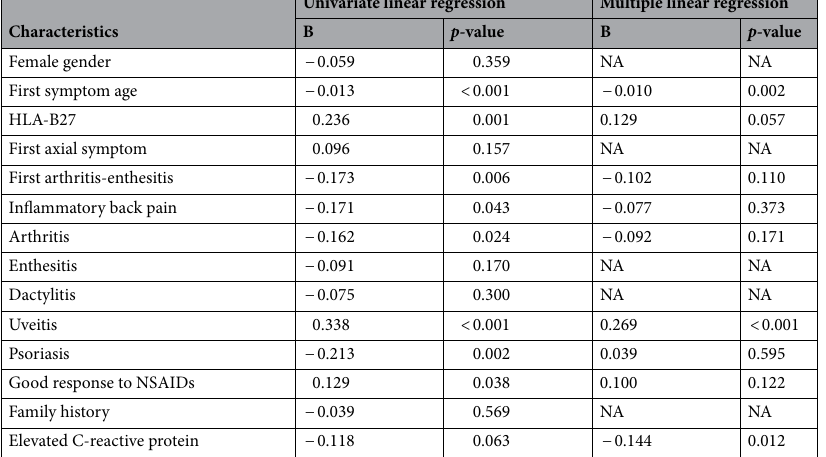
Table 3. Factors associated with duration of delayed diagnosis in 177 patients with axial spondyloarthritis. log 10 transformation data. B unstandardized coefficients, Family history presence in first-degree or second-degree relatives of any of the following: ankylosing spondylitis, psoriasis, uveitis, reactive arthritis, or inflammatory bowel disease, First axial symptom first presentation with inflammatory back pain and/or buttock pain, First arthritis-enthesitis first presentation with peripheral arthritis or enthesitis, First symptom age age at onset of the first musculoskeletal symptoms, NA not applicable, NSAIDs non-steroidal anti-inflammatory drug. A p -value < 0.05 indicates statistical significance. Linear regression analysis was used to identify significantly associated factors with the duration from the first musculoskeletal symptom to diagnosis; the dependent factor was the duration from the first musculoskeletal symptom to diagnosis.